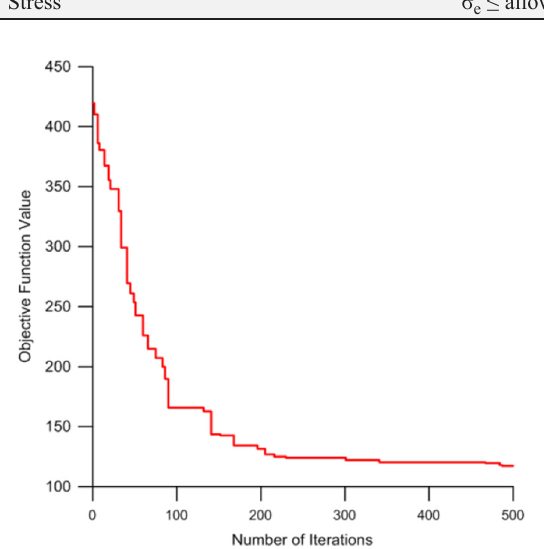
Fig. 10. Convergence history for the spatial 25-bar truss